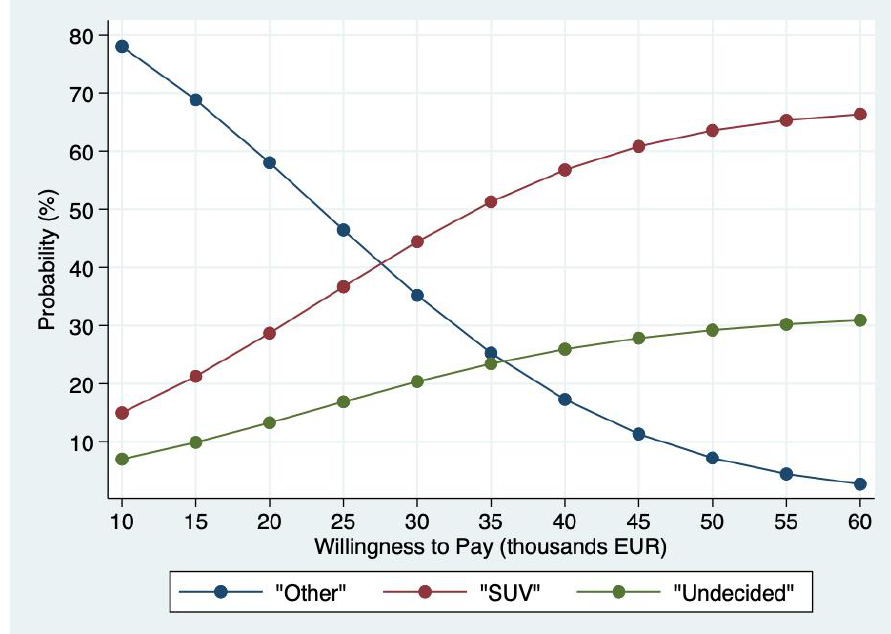
Figure 5. Predictive margins. Willingness to pay.